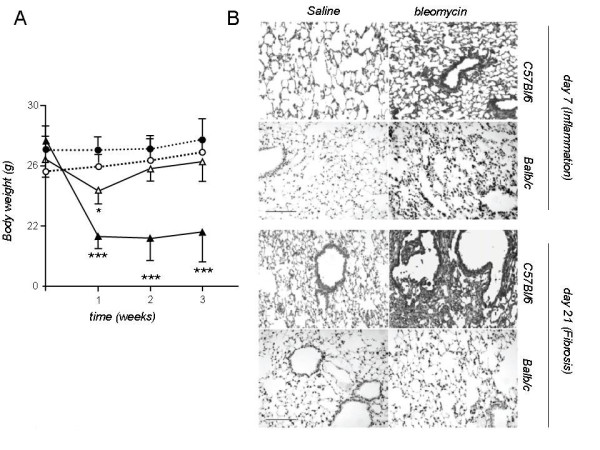
Changes in body mass and lung microstructure after intratracheal bleomycin to a sensitive (C57BL/6) and a resistant (Balb/c) mouse strain. C57BL/6 (n = 38) and Balb/c (n = 32) mice received single doses of 2 mg/kg intratracheal bleomycin or saline control (injection volume = 50 μl). A. Both C57BL/6and Balb/c developed early weight loss after bleomycin (but not saline). Only C57BL/6mice displayed persistent cachexia after bleomycin. B. Representative histologic images of lungs at early (7 days after intratracheal bleomycin), and late (21 days after intratracheal bleomycin, respectively) time-points. (Scale bar = 200 μm). (***P < .001 compared with C57BL/6 N/S; *P < .05 compared with Balb/c N/S). Data points, mean; bars, SD. Solid Circles: C57BL/6-Saline; Open circles: Balb/c-saline; Solid triangles: C57BL/6-bleomycin; Open triangles: Balb/c-bleomycin).